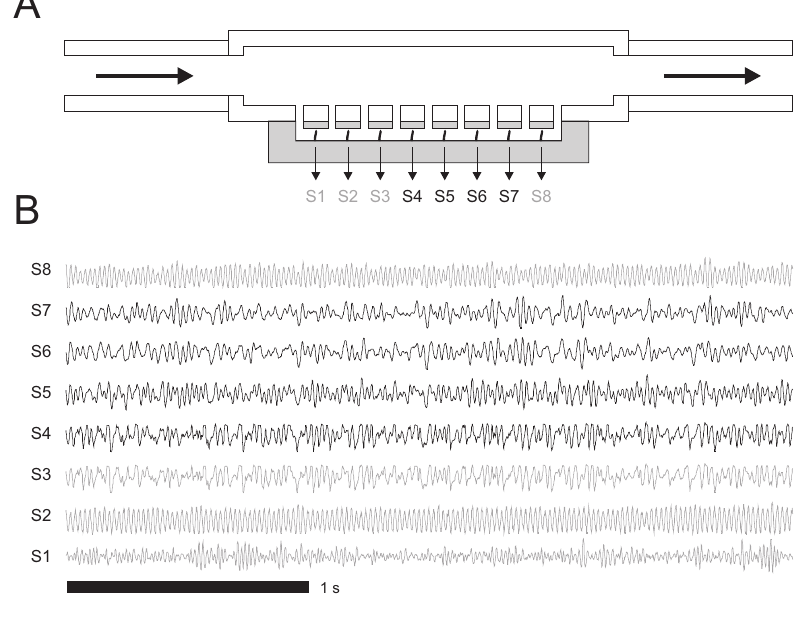
Figure 4. Measuring setup and original recording traces obtained in the proof of principle